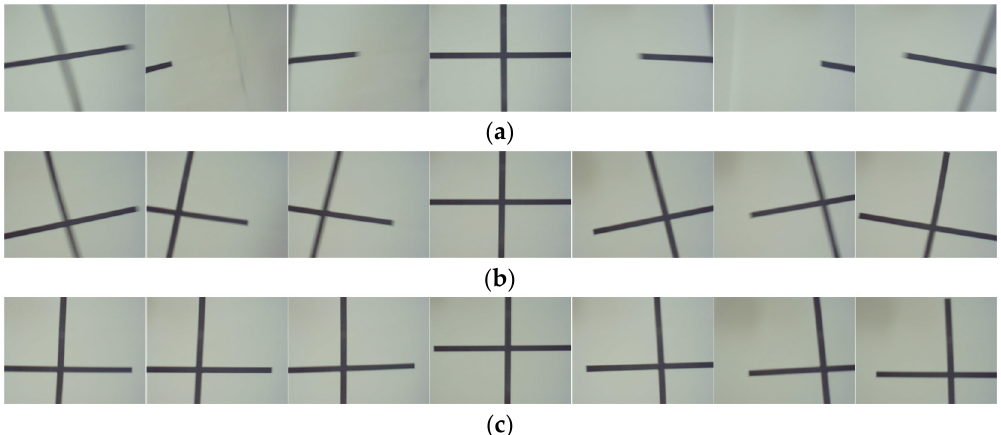
Figure 7. Comparison of the different visual sensor stabilization platform experiments. ( a ) The system without mechanical stabilization and digital stabilization; ( b ) The pure 1-DOF mechanical stabilization system; and ( c ) The system combining mechanical stabilization with digital stabilization.